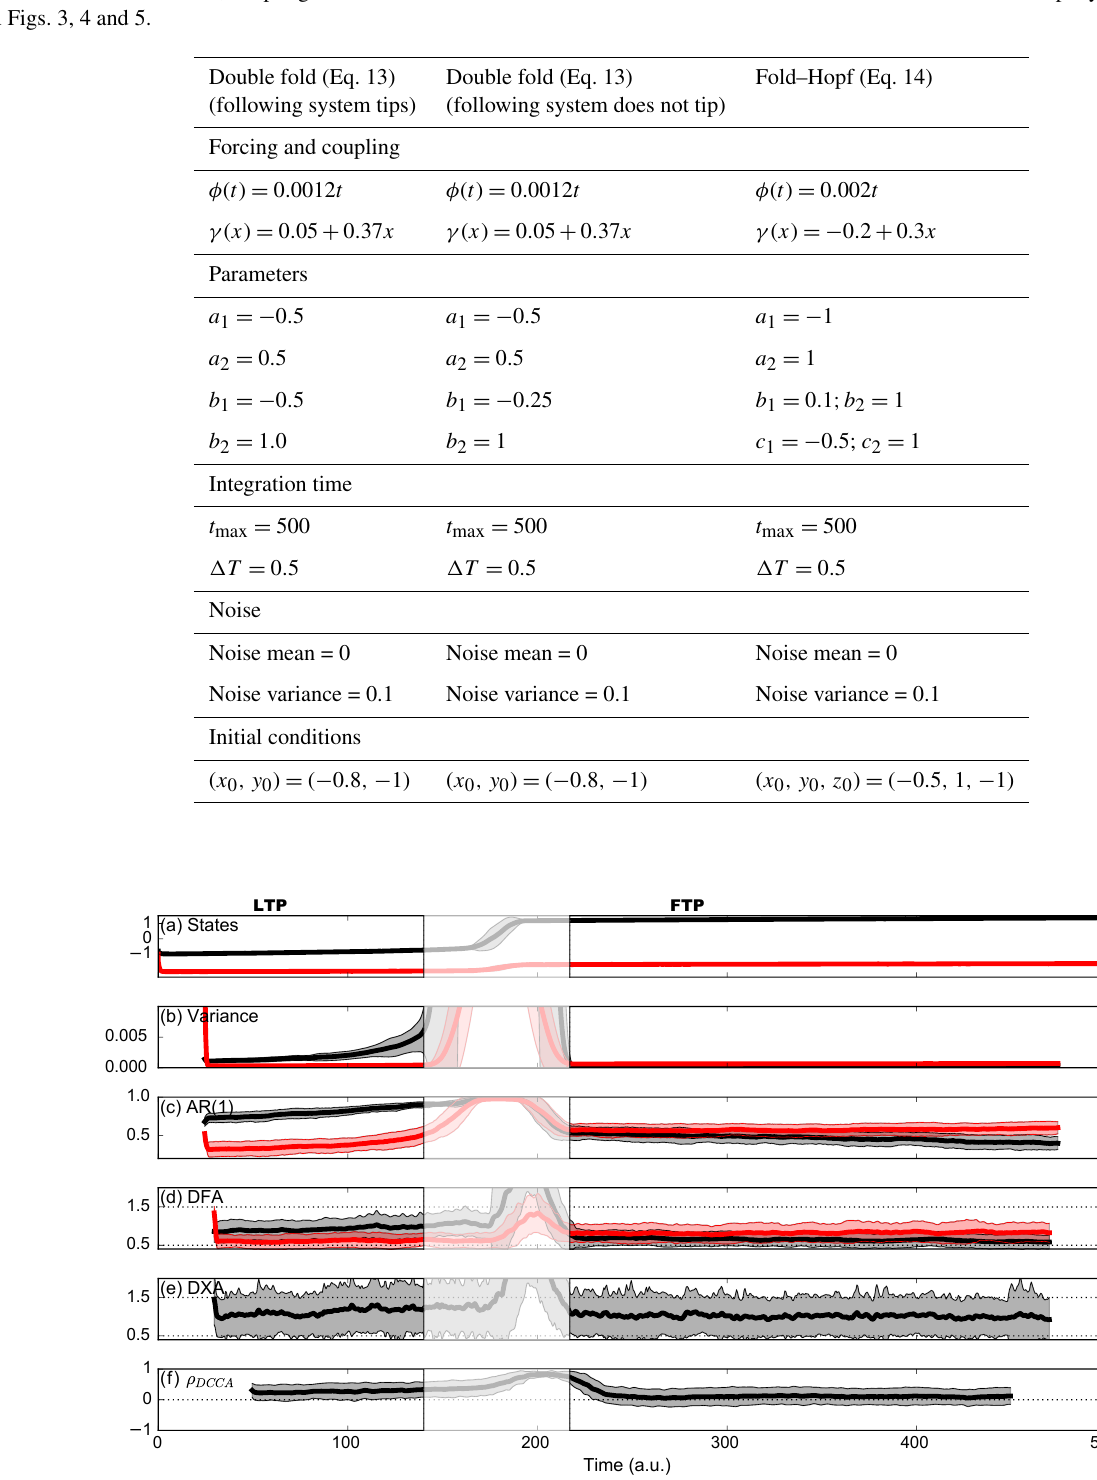
Figure 4. As in Fig. 3, but without any transition in the following system. In this case, only the leading system has a transition. Parameter values are given in Table